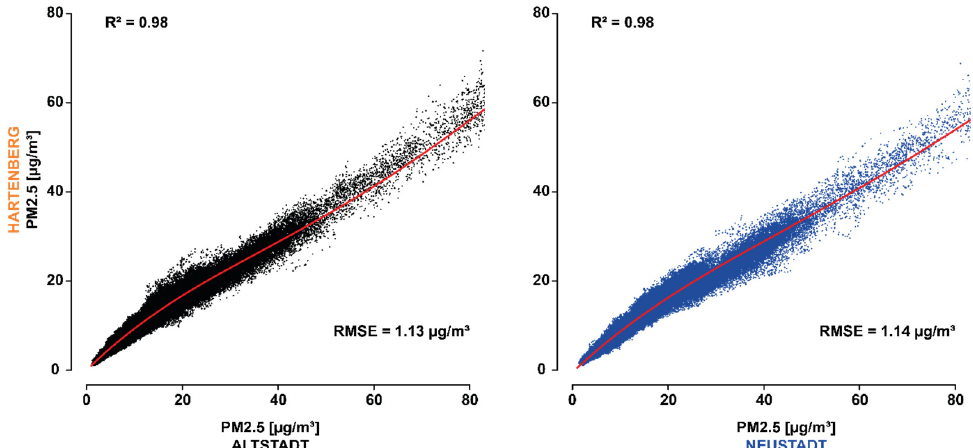
Figure 3. Scatter plots and polynomial regressions of the moving 20 s truncated arithmetic mean PM 2.5 adjustments of the sensors used on the Altstadt ( left panel) and Neustadt tracks ( right panel) to the Hartenberg sensor including R 2 coefficients and root mean square errors for the adjustment periods from 18–22 November 2020, 5–8 January 2021, and 20–23 February 2021.